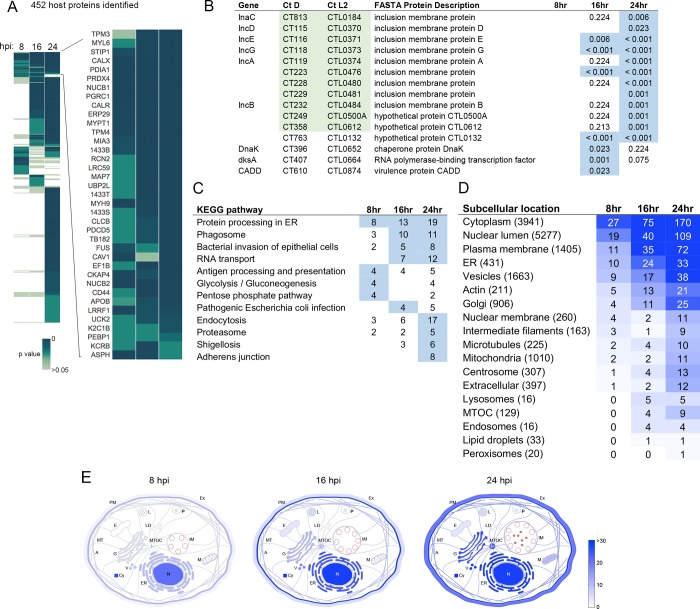
Global analysis of the inclusion membrane interaction proteome throughout the C. trachomatis developmental cycle.(A) Heatmap of inclusion membrane interacting proteome identified by APEX2 at 8, 16, and 24 hpi. Data from 6 replicate experiments per time point were averaged and compared against 6 replicate controls at similar times. Colors represent p-values, proteins not detected have no color. Enlarged section of heatmap shows proteins significantly enriched at all time points. Significance determined by t-test or g-test, p < 0.05. (B) C. trachomatis ORFs identified on the inclusion membrane, with p values displayed for their presence in 6 replicate samples for each time point. Locus tags highlighted in green represent annotated Inc proteins. Values highlighted in blue represent p values < 0.05. (C) KEGG pathway overrepresentation analysis of inclusion membrane proteome. Overrepresentation determined by hypergeometric algorithm with Benjamini Hochberg method for multiple test correction. Values highlighted in blue represent p values < 0.05. (D) Subcellular location enrichments of APEX2 identified proteins. Color intensity reflects the number of proteins for each location annotation pulled from the Human Protein Atlas database. Numbers in parentheses indicate the total number of reference proteins contained under that annotation in the Human Protein Atlas database. (E) Spatial distribution of inclusion interacting proteins from 8–24 hpi using Human Protein Atlas annotations and manual entry of Inc proteins. Color intensity indicates the number of proteins assigned to location annotations. A, actin filaments; Cy, cytosol; E, endosomes; ER, endoplasmic reticulum; Ex, extracellular/secreted; G, Golgi apparatus; IM, inclusion membrane; L, lysosomes; LD, lipid droplets; M, mitochondria; MT, microtubules; MTOC, microtubule organizing center; N, nucleus; P, peroxisomes; PM, plasma membrane; V, vesicles.